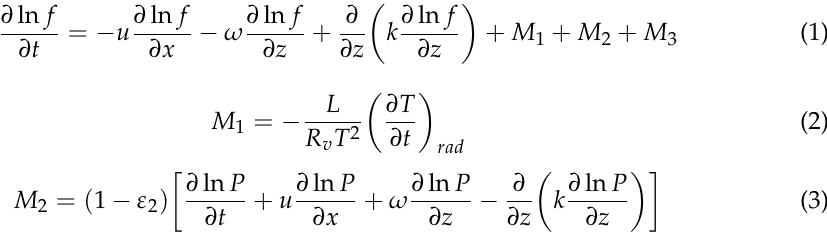
Table 1. Numerical simulation experimental design.